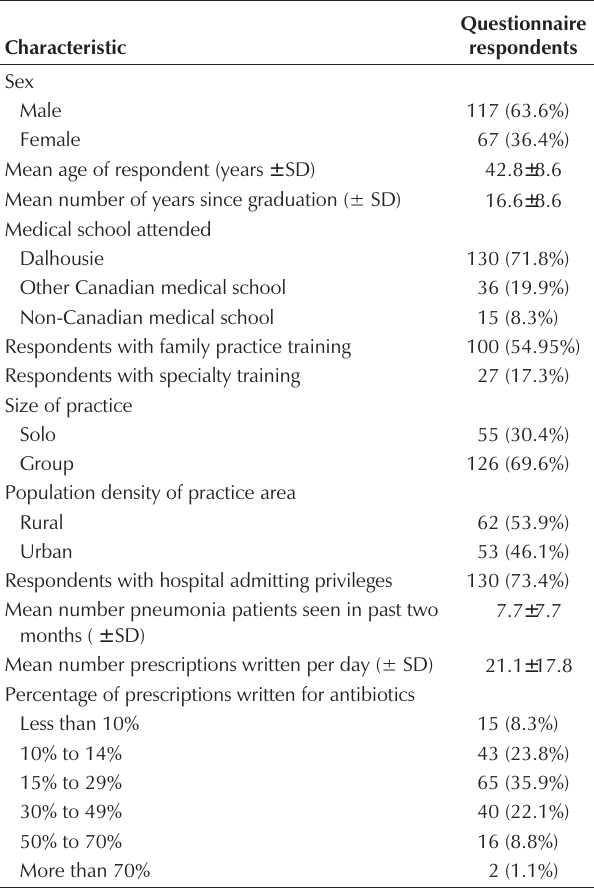
Characteristics of physicians who completed case-based questionnaires regarding antibiotic choice to treat community-acquired pneumonia (n=184)